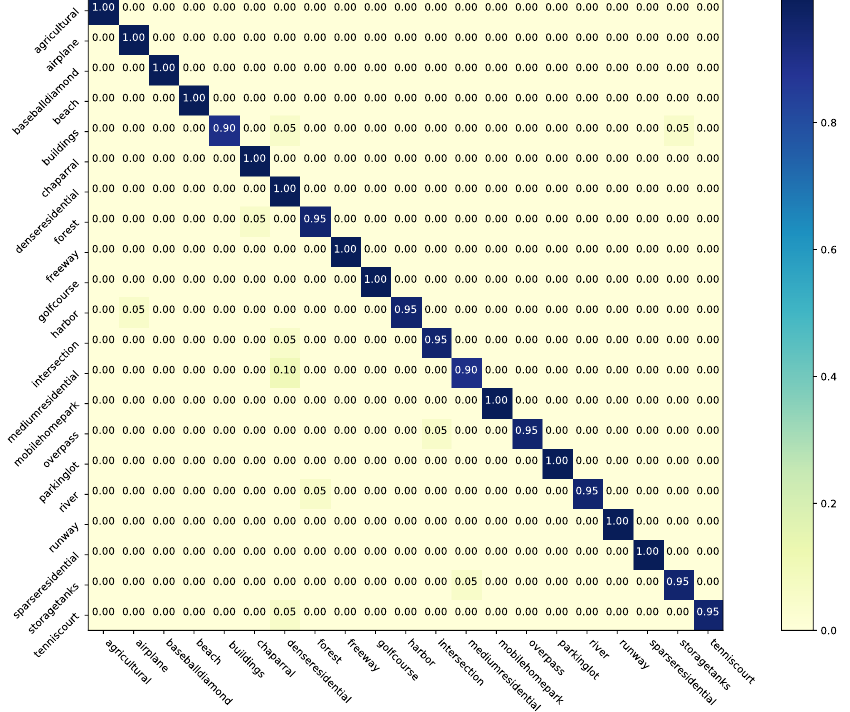
Figure 7. The confusion matrix of Baseline-Clean with full UC Merced Land-use dataset.